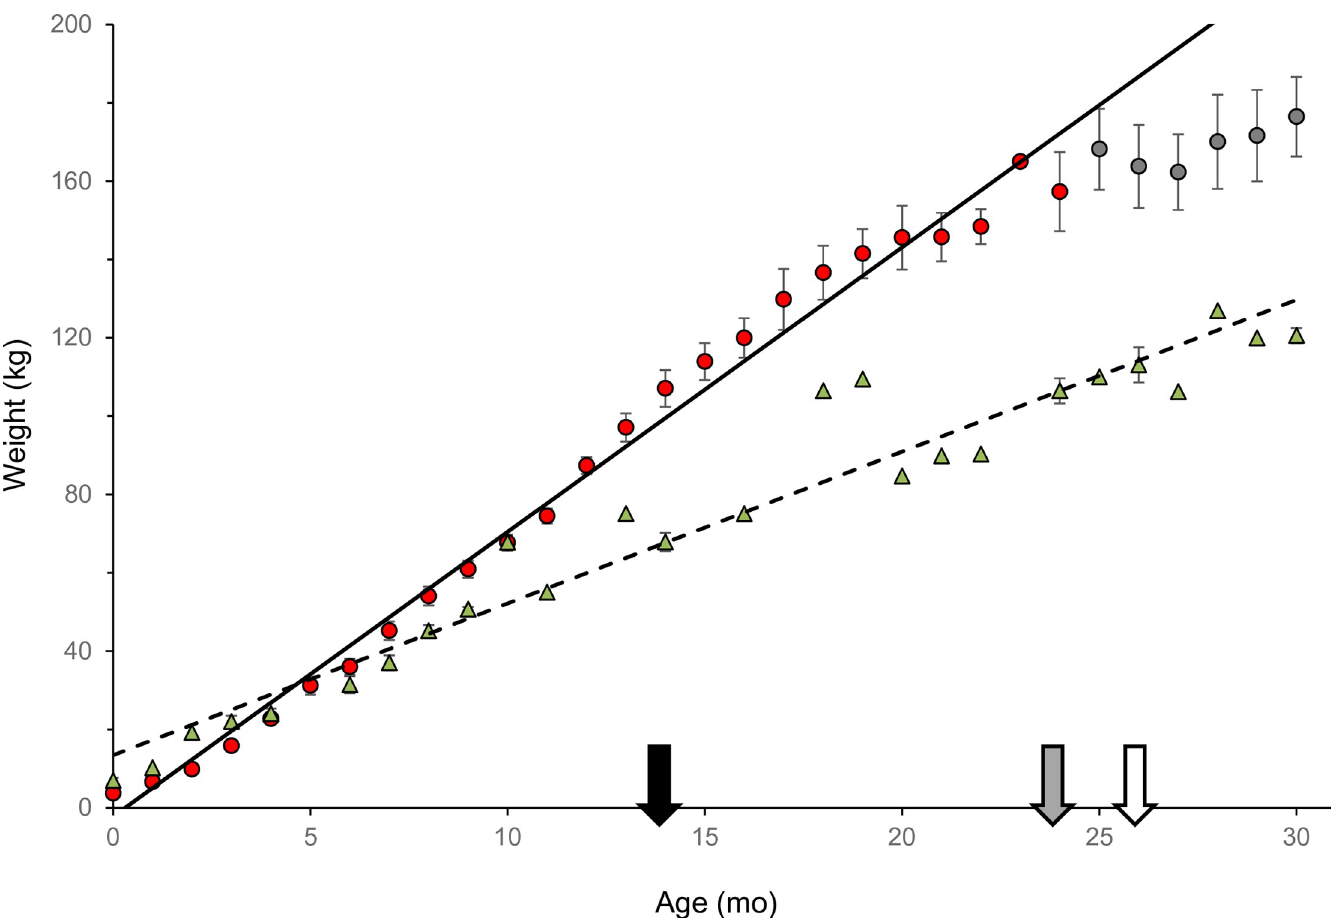
Fig 2. Monthly average ( ± SE) body weights (kg) of captive (circles, N = 11) and wild (green triangles; adapted from Smuts et al., 1980; N = 26) male lions through 30 mo (2.5 yr) [10]. Red circles denote months when captive males were actively gaining weight and grey circles represent months where the rate of weight gain slowed. Trend lines are solid for captive lions and dashed for wild lions. The black arrow indicates the earliest age, 14 mo (1.2 yr), and body weight, 105 kg, at which spermatozoa were present in captive male urine (n = 2). The grey arrow denotes when spermatogenesis should be occurring in wild lions based on the age, 24 mo (2.0 yr), at which they reach ~105 kg and the open arrow is the age (26 mo, 2.2 yr) and body weight (113 kg) when males reach puberty in the wild based on behavioral observations [10] and the earliest age spermatozoa were found in seminiferous tubules in wild males [16]. (Modified data on wild lions by Smut et al., used with permission from John Wiley and Sons)